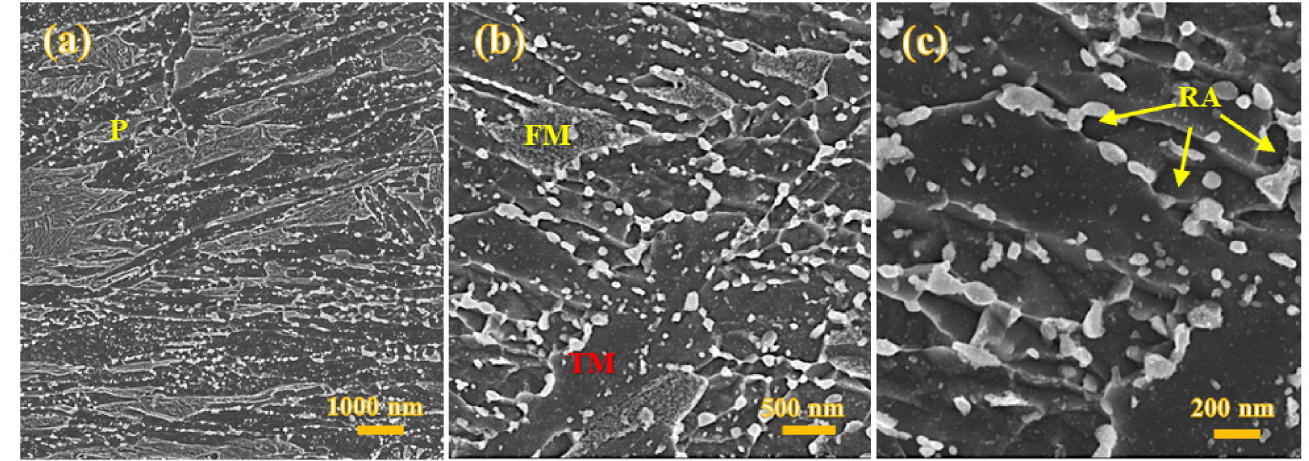
Figure 4. FE-SEM micrographs of the Def-A600 sample showing pearlite (P), tempered martensite (TM) some fresh martensite (FM), and several carbides on the lath boundaries and inside the laths ( a , b ), recrystallized ferrite and equiaxed retained austenite (RA) nucleated on carbide/ferrite boundaries and presence of very fine carbides inside the TM, ferrite, and RA grains ( c